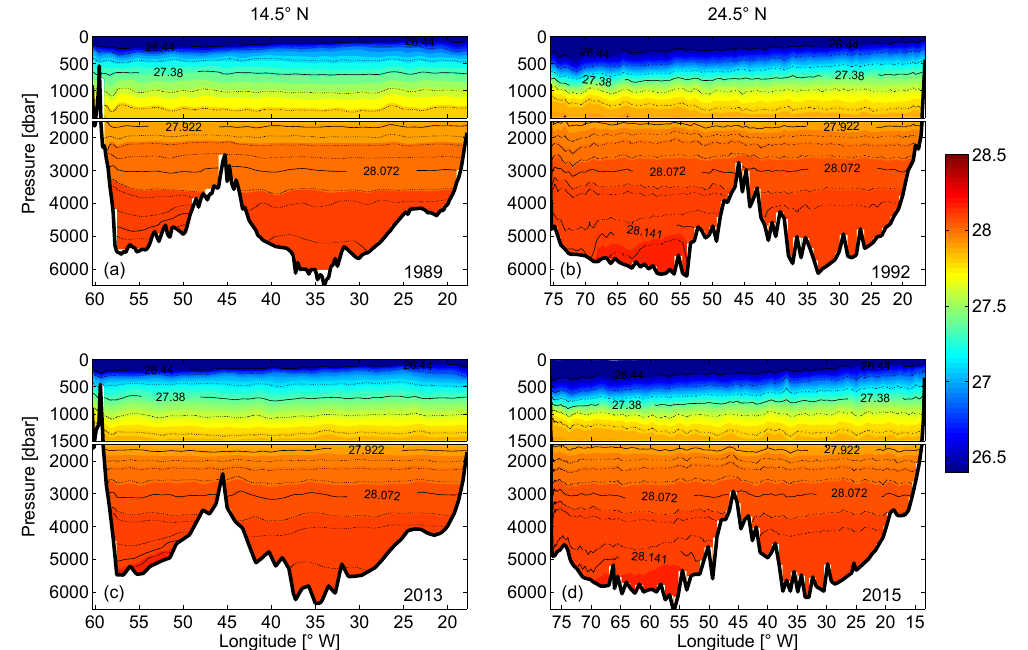
Figure 6. Vertical sections of neutral density (kgm − 3 ) at 14.5 ◦ N in (a) 1989 and (c) 2013 and at 24.5 ◦ N in (b) 1992 and (d) 2015. The upper 1500m in each subplot is stretched.